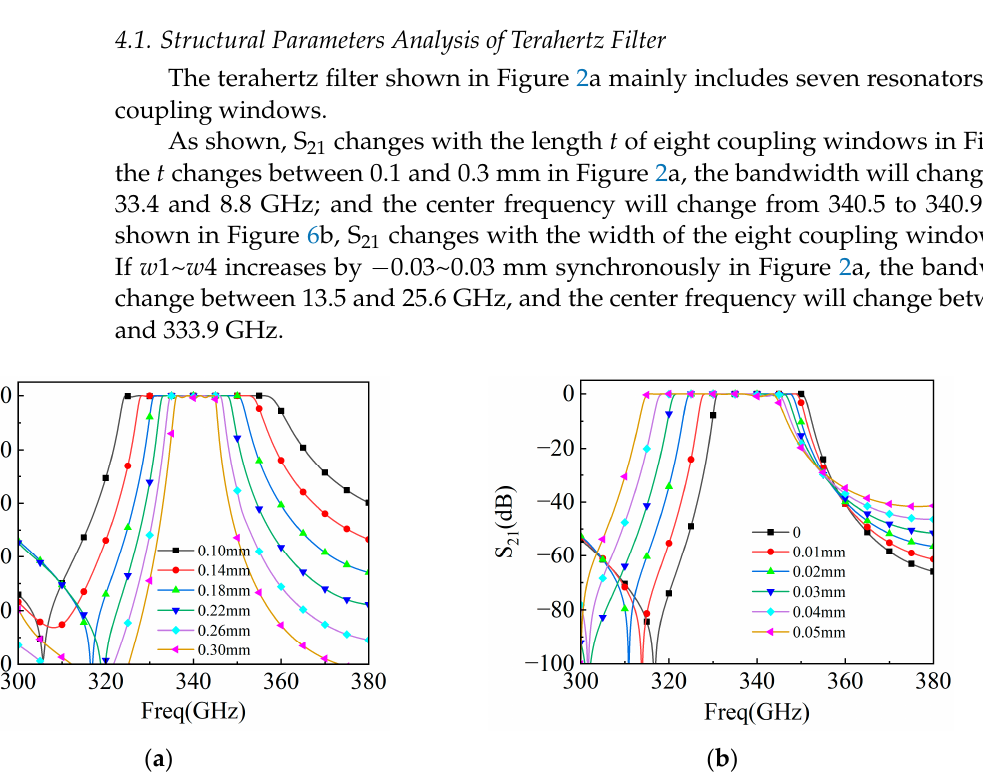
Figure 5. Second fabricated terahertz filter. ( a ) Fabricated terahertz filter based on GOC method; ( b ) Comparison between measured and simulation results; ( c ) Comparison between measured and desired results.